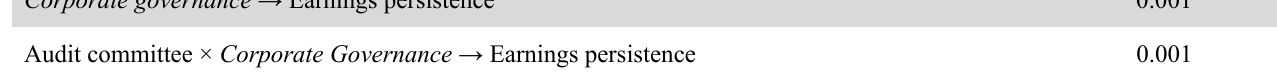
Result Regression Corporate governance → Earnings